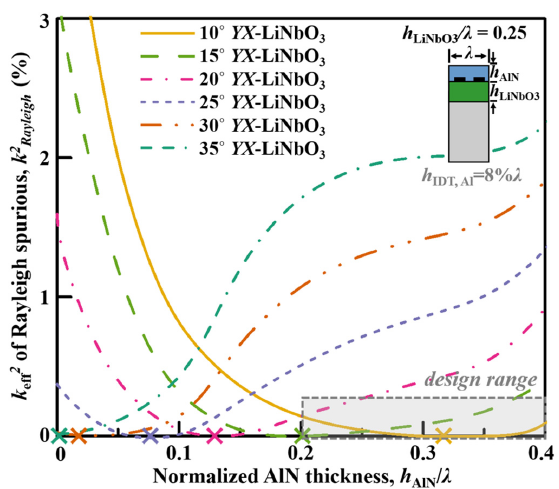
Figure 9. Simulated k eff2 of the Rayleigh spurious mode versus AlN thicknesses for the AlN/ LiNbO 3 /Si with different rotation angles and h LiNbO3 / λ = 0.25. The cross labels mark the AlN thick- nesses that enables full suppression of the Rayleigh mode.